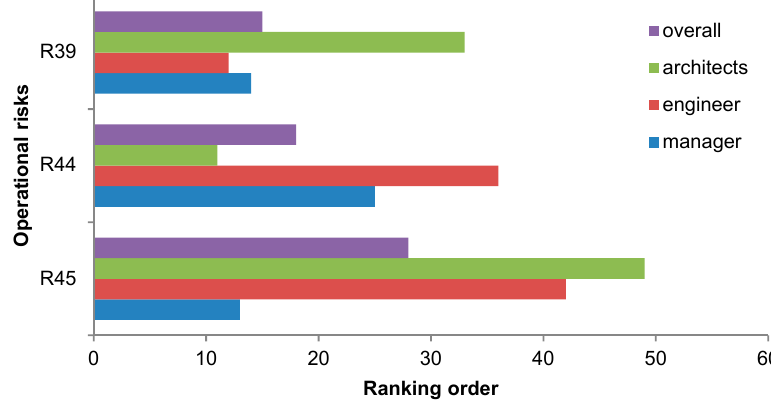
Figure 6. Ranking the operational risk factors impacting on the project value.